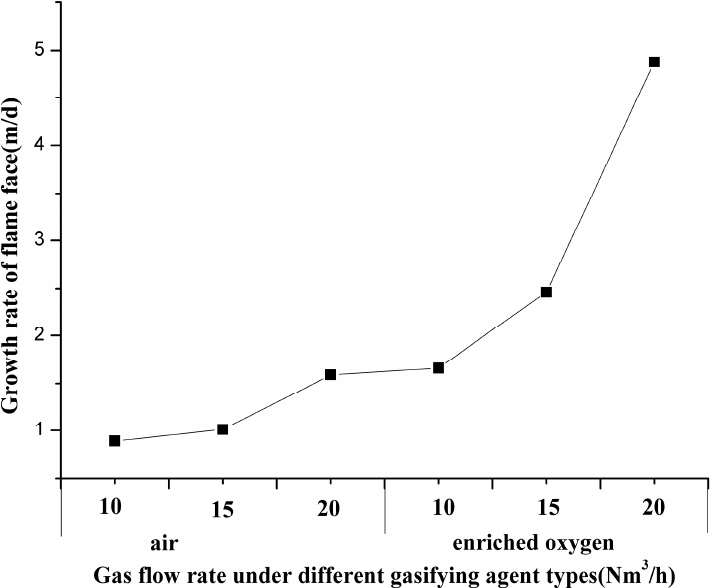
Figure 7. Changes in the growth rate of the flame front during the reverse UCG process.